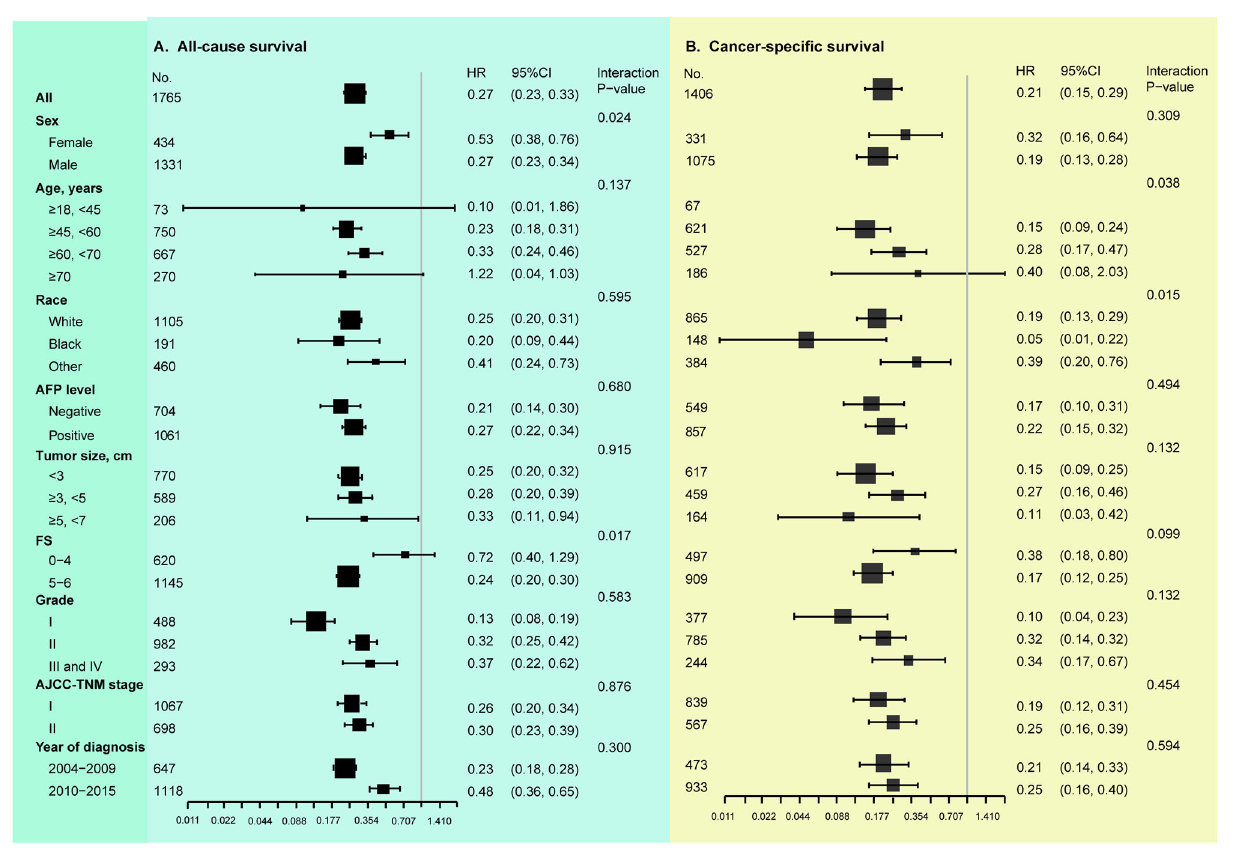
FIGURE 4 | Strati fi ed analysis based on clinicopathologic features (multivariable COX analyses). (A) Results of LT vs. LR on overall survival. (B) Results of LT vs. LR on disease-speci fi c survival. AFP, alpha-fetoprotein; FS, fi brosis score; AJCC, American Joint Committee on Cancer. Tumor grade: I, well-differentiated; II, moderate- differentiated; III, poor-differentiated; IV, un-differentiated. In subgroup analysis, all identi fi ed confounders were adjusted except for the factor that the subgroup was based